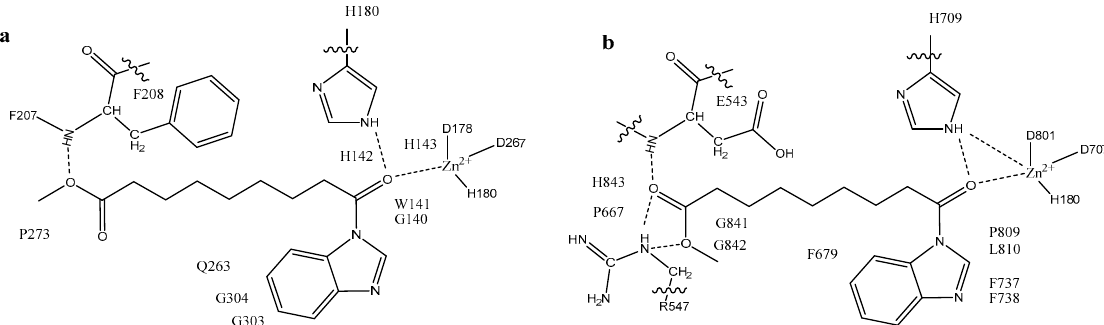
Figure 7 . Hydrogen bond and chelation interactions in the active site of ( a ) complex 8a –HDAC8-4QA3, and ( b ) complex 8a –HDAC7-3C0Z. Amino-acid residues within 5 Å are indicated without a dashed line.